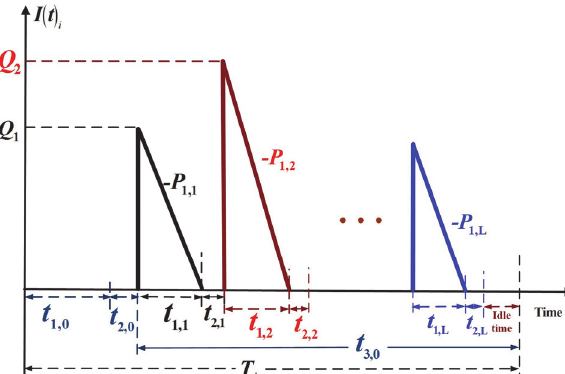
Fig. 2. The separate common part’s stock status during the manufacturing process of each end product i .